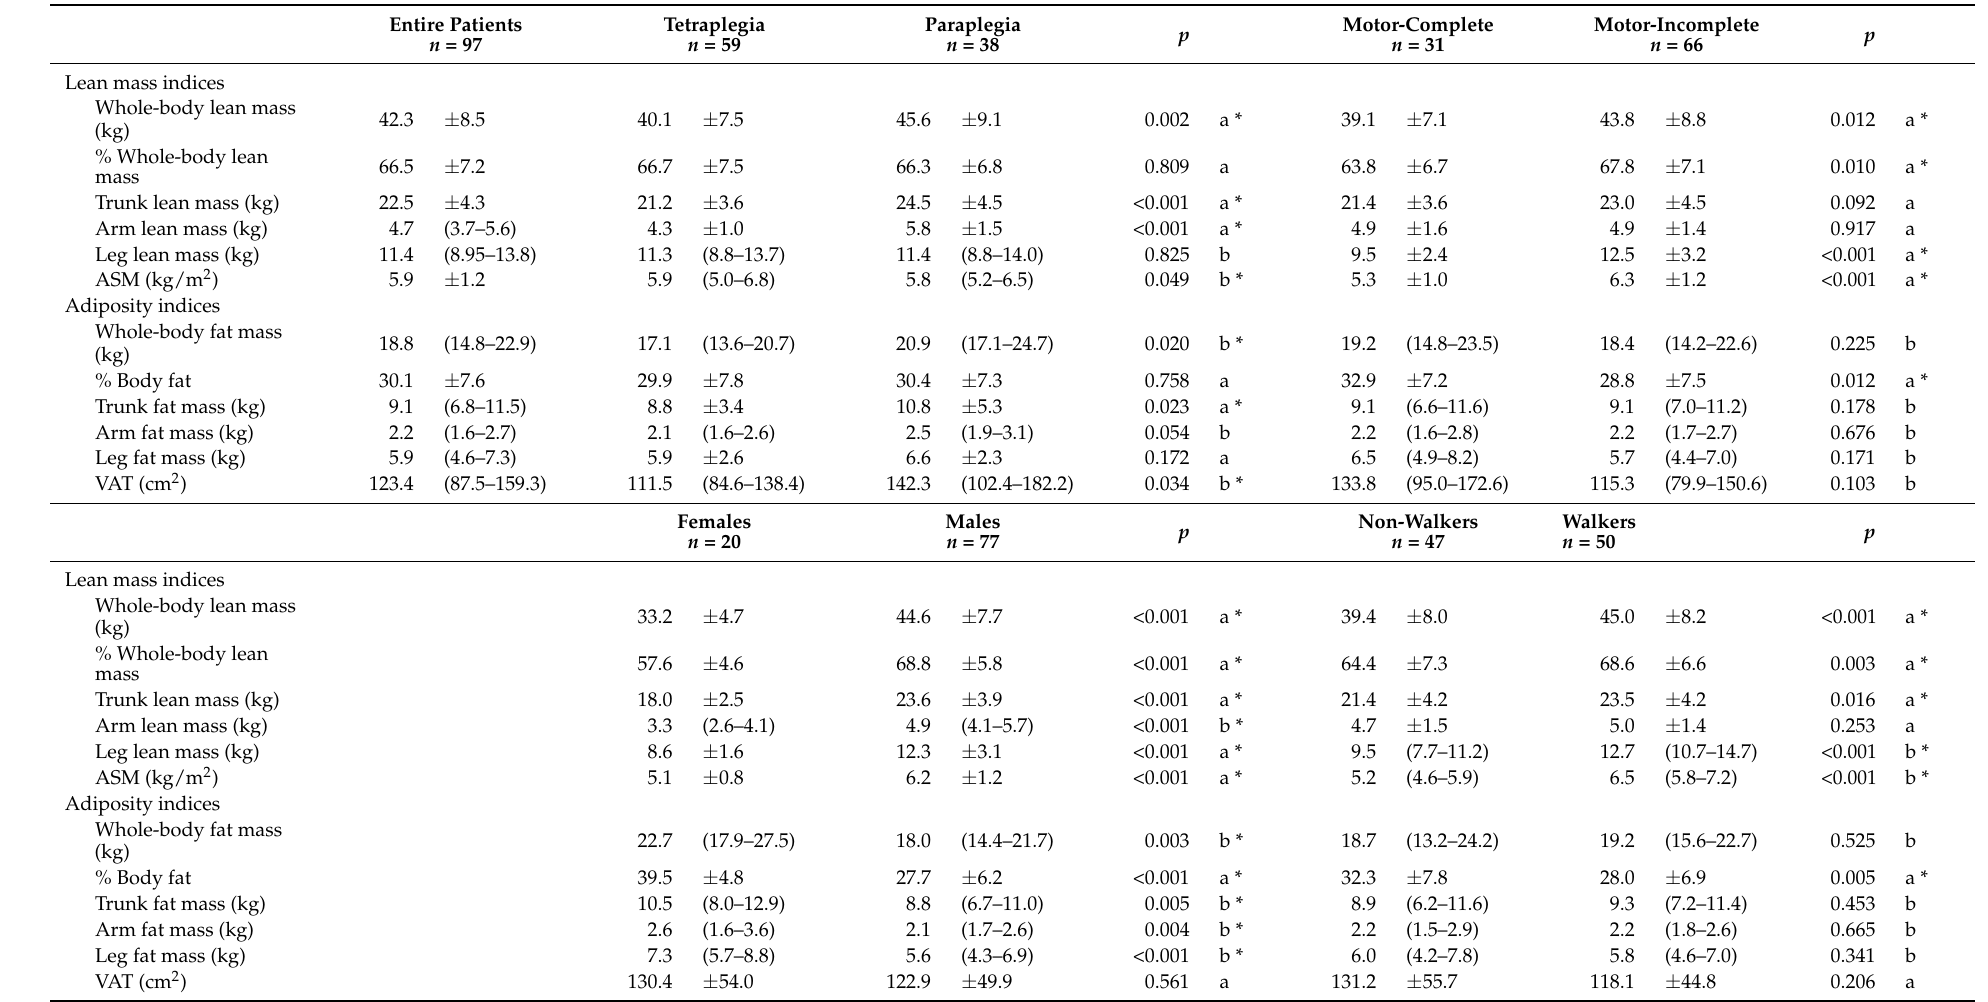
Table 3. DXA-measured body composition